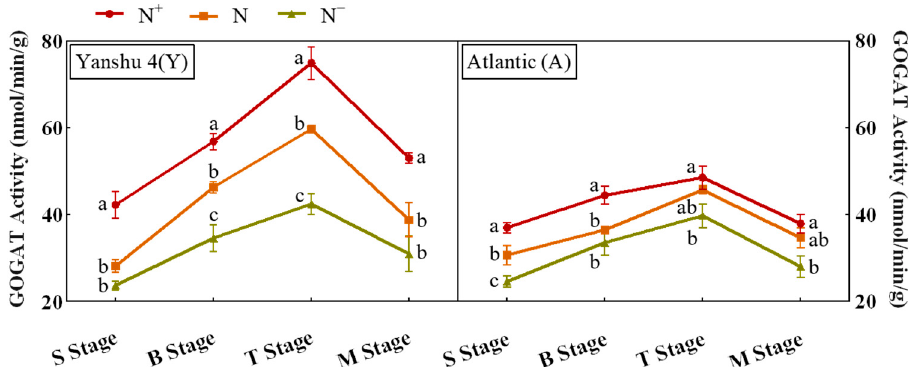
Figure 18. Glutamate synthase (GOGAT) activity in two genotypes of potato leaves under different N supply levels. The amount of 1 nmol NADH is consumed per 1 g fresh weight sample per 1 min is one unit of enzyme activity. S Stage, B Stage, T Stage, and M Stage represent seedling stage, bud- ding stage, tuber expansion stage, and mature stage, respectively. N − , N, N + are different N supply levels, representing low N, normal N, and excess N, respectively. Different letters indicate the dif- ference of enzyme activity under different N application levels in the same period ( p < 0.05).